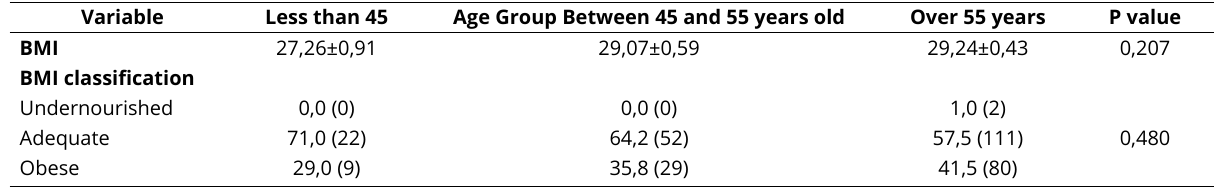
Table 2. Assessment of the relationship between age group and BMI of the patients evaluated in this study. Variable